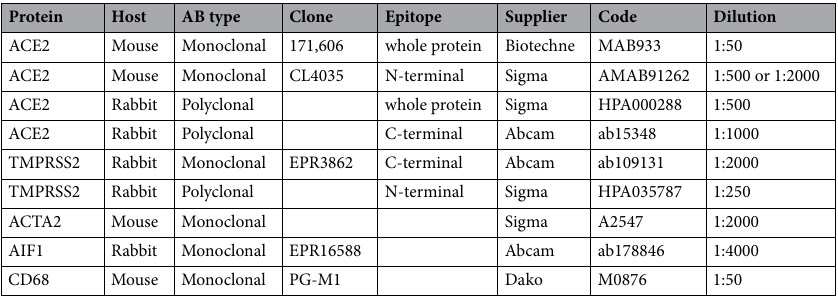
Table 1. Antibodies. Antibodies #MAB933 and #HPA000288 were produced using the same